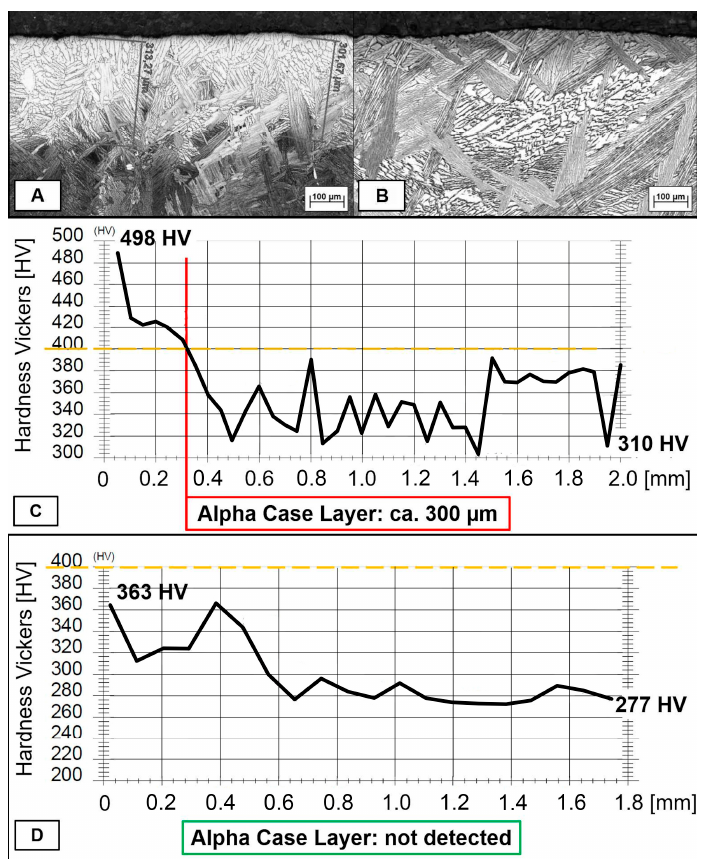
Figure 3. Microstructure analysis (Light Microscopy 100x magnification; Micro-Hardness) ( A , C ) Microstructure before process optimization, thickness of Alpha Case Layer critical (>15 µm); ( B ) and ( D ) Microstructure after process optimization, no Alpha Case detectable (Hardness Vickers, Load: HV0.10, Obj. 50×).